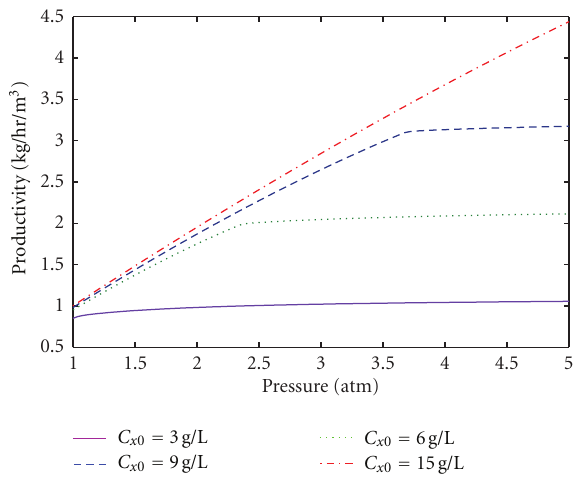
Figure 7: E ff ect of pressure on the reactor productivity for di ff erent